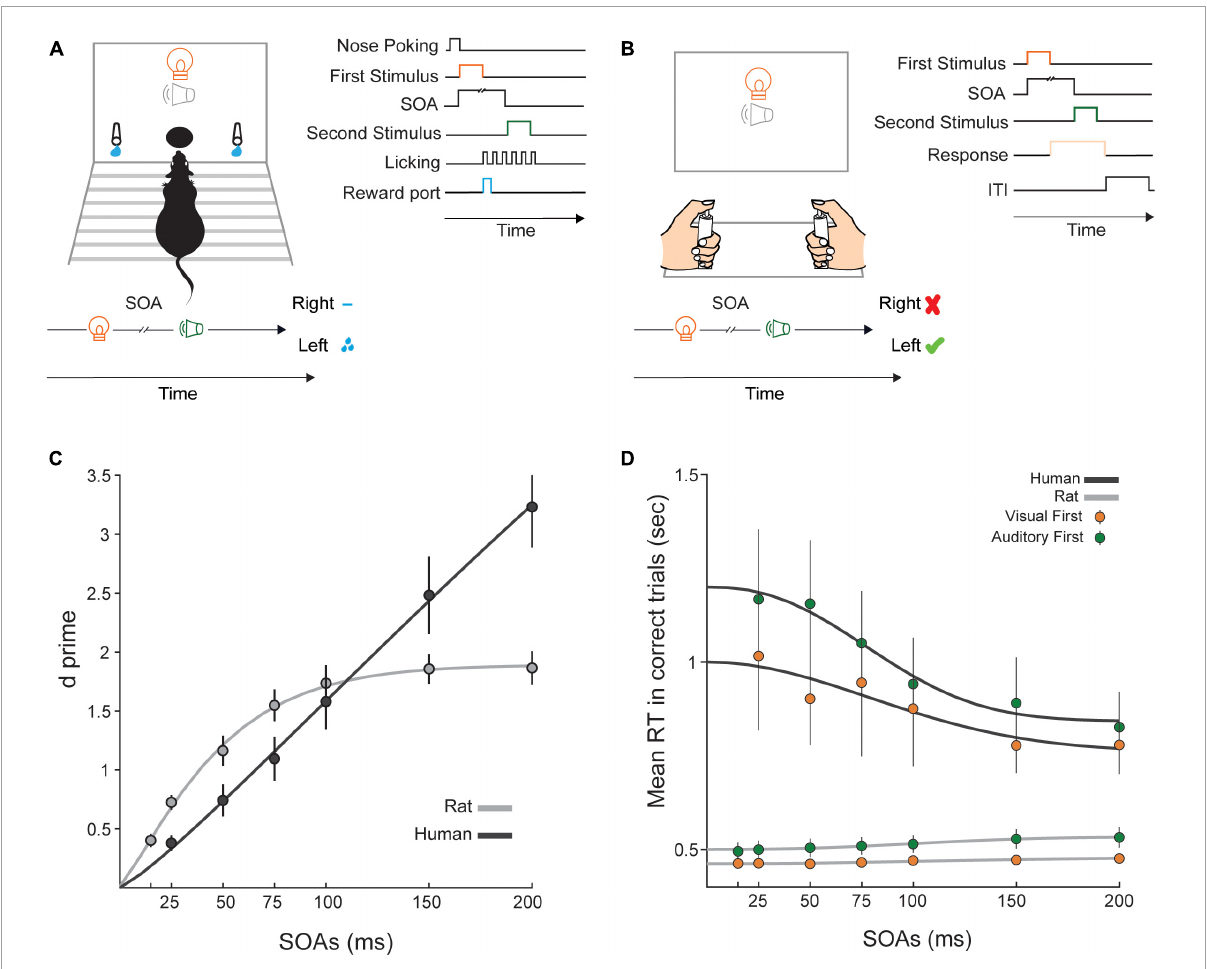
FIGURE1 Temporal discriminability and reaction time in the audio-visual TOJ paradigm. (A) Schematic illustration of the experimental setup in rats. (Left) In the middle of the front panel of the testing chamber, there was a central hole for nose pokes. One LED and one speaker were positioned above the nose poke area. On either side of the nose poke area there were two spouts for collecting rewards (0.02 ml sucrose 5%). Also, schematic representation of a visual-leading trial in a subgroup of rats indicates that visual choices are mapped to the left spout. For another subgroup, a reversed contingency (not shown) was applied. (Right) Each trial included an auditory and a visual stimulus which were presented at a specific temporal delay (SOA) from each other. Each trial started with a nose poke that triggered the first stimulus presentation followed by the presentation of the second stimulus after the specific SOA. Rats could respond after the presentation of the first or the second stimulus by moving towards the left or right spout. (B) Schematic illustration of the human setup. (Left) Participants sat in front of a panel which had a central speaker and an LED. Left and right response keys, 45 cm apart, recorded participants’ responses. (Right) Each trial included one auditory and one visual stimulus which were presented at a specific SOA. Participants could respond after the presentation of the first or the second stimulus by pressing the right or left keys. (C) d’ as a function of SOA. Higher values indicate more accurate detection of the temporal order of stimuli. Black circles indicate the averaged d’ value for humans and the black line shows the fitted curve to d’ values across SOAs. Gray circles indicate the averaged d’ value across rats and the gray line shows the fitted curve to d’ values across SOAs. (D) Average reaction time (RT) of correct responses across rats and humans. Green color indicates RT of auditory first trials and orange color shows RT of visual first trials. Black lines show fits to human data and gray lines show fits to rat data. Error bars indicate ± SEM across